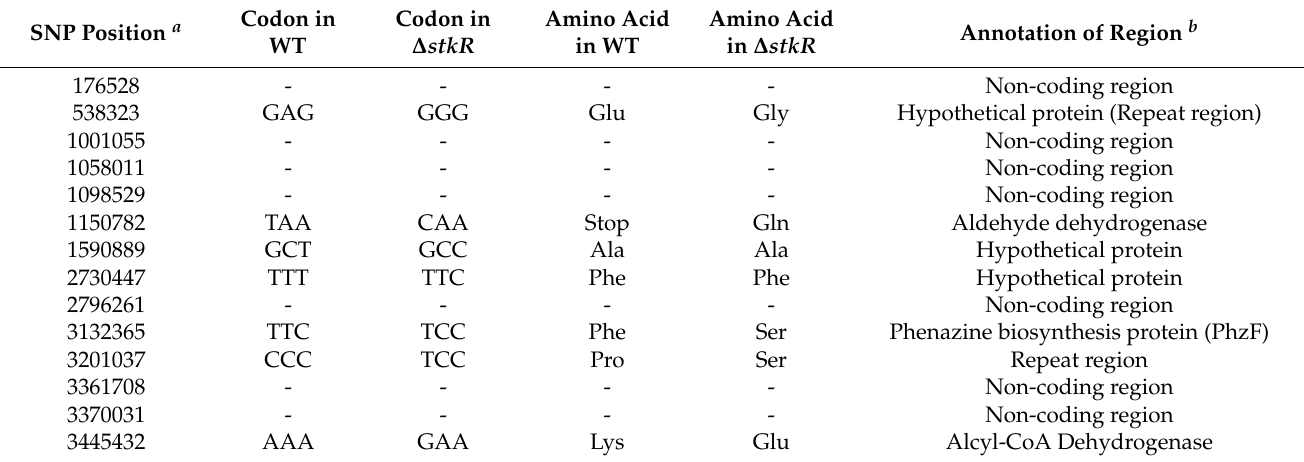
Table 4. Single nucleotide polymorphisms regions identified in the ∆ stkR mutant compared to the WT